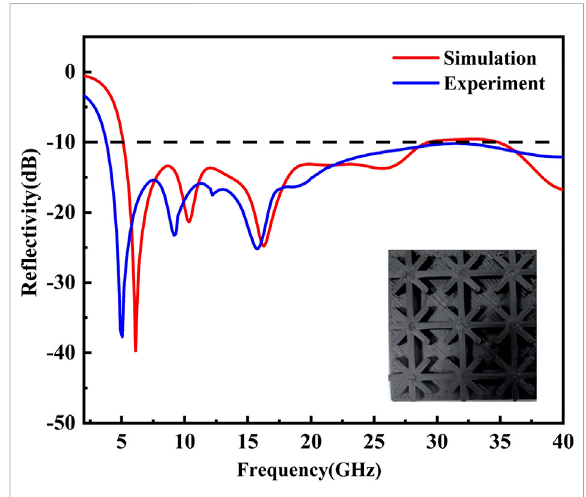
FIGURE 4 Comparison of the simulation and experimental re fl ectivity the double-cross shape metamaterial structure in the frequency range of 2 – 40